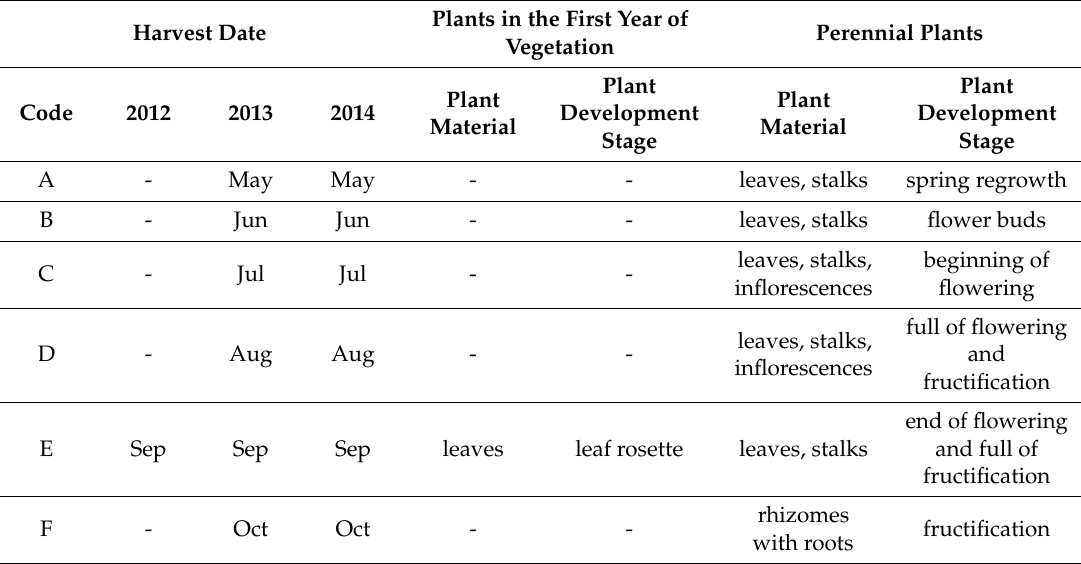
Table 1. Dates of plant material harvest for chemical studies (the first decade of the month)